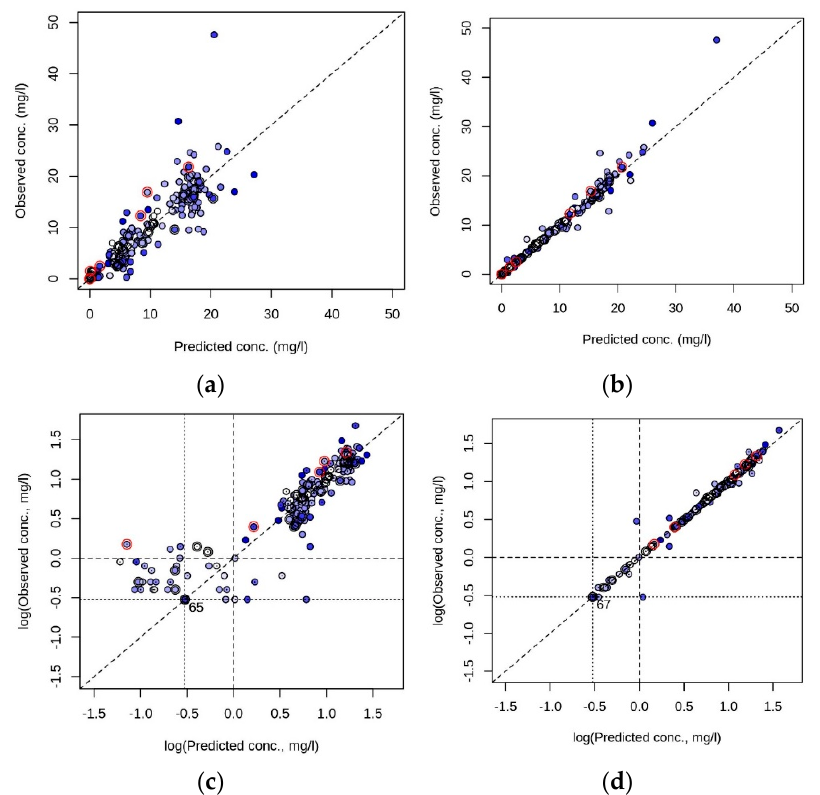
Figure 3. Comparison between measured (observed) and simulated (predicted) gentamicin plasma concentrations on the population ( a , c ) and individual ( b , d ) levels, in linear ( a , b ) and logarithmic ( c , d ) scales. Blue, light to dark indicates lowest to highest age. Black circle around symbol, gestational age at birth < 37 weeks. Red circle around symbol, serum creatinine > 50 µ M. Diagonal line, line of unity. ( c , d ) Dot within a symbol, male; dotted lines, LOQ (0.3 mg/mL); broken lines, recommended maximal trough level (1 mg/L); number at LOQ intercept, number of data points at LOQ intercept (number of C ( t ) with measured and simulated value ≤